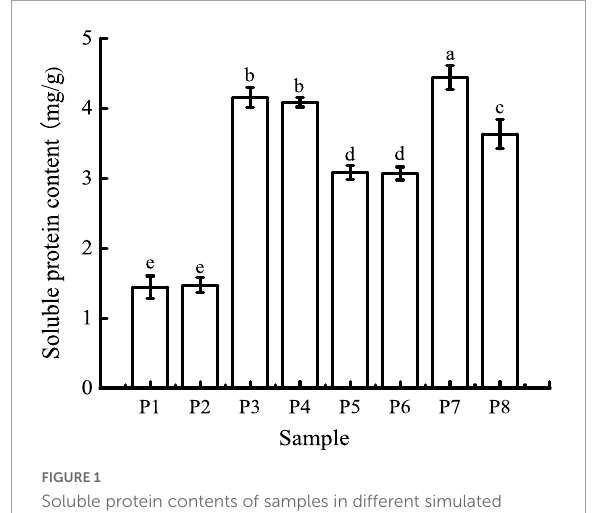
FIGURE1 Soluble protein contents of samples in different simulated digestion stages. P1 was the initial sample of unfermented black bean control and P2–P4 were the control samples following the simulated buccal, gastric, and small intestinal digestion. P5 was the initial sample of black bean tempeh and P6–P8 were the tempeh samples following the simulated buccal, gastric, and small intestinal digestion, similarly hereinafter. Data with different lowercase letters indicate significant differences ( P <